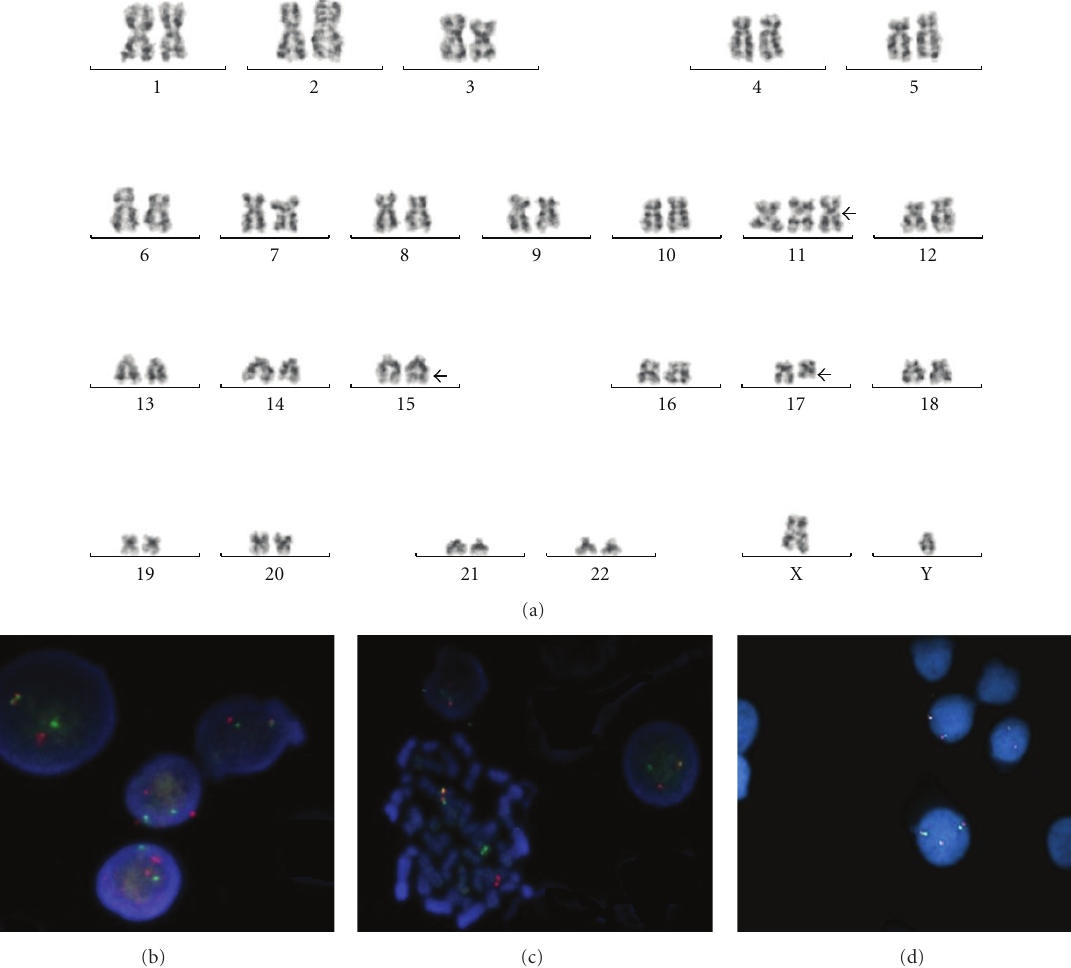
Figure 1: (a) Karyotype of bone marrow cell by G-banding showing 47,XY,+11,t(15; 17)(q22; q21). (b, c) Hybridization of LSI PMLRARA dual-color DNA probe (Cytocell, Cambridge, UK). The probe hybridizes to chromosome 15q11 (SpectrumOrange PML ), 17q21.1 (SpectrumGreen RARA). Fusion signal of PML/ RARA gene was clearly observed in 70% of the nucleus and metaphases. (d) Fish using LSI MLL dual color break-apart probe. Nucleus with three and others with two signals, confirming trisomy 11 in some of